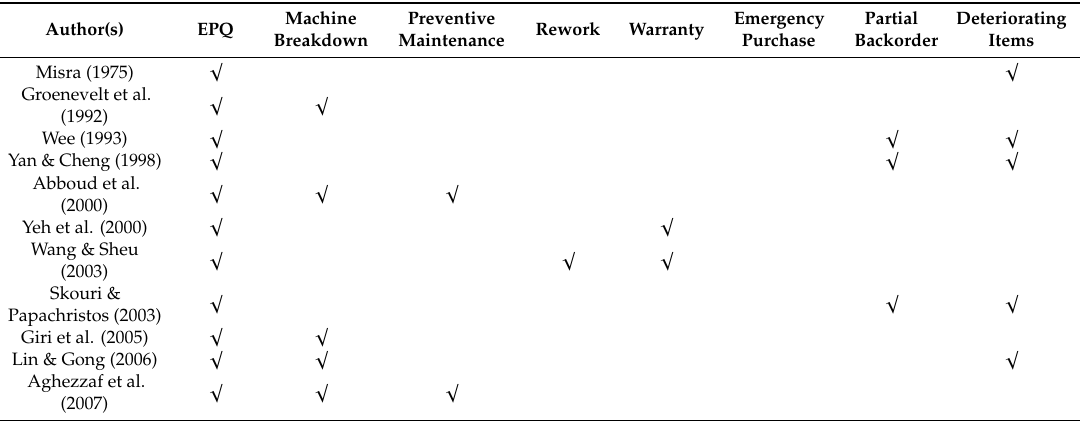
Table 1. Contribution of selected